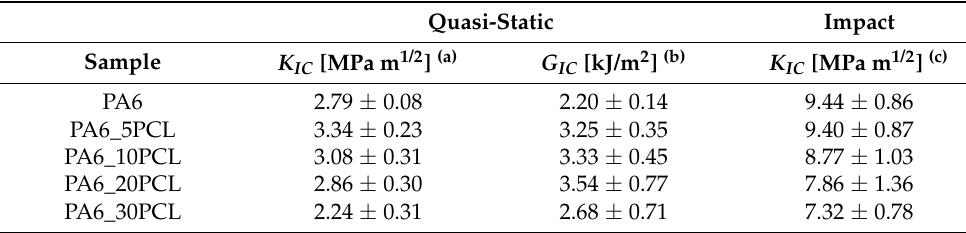
Table 3. Results describing the fracture behavior of the prepared PA6/PCL blends in quasi-static and impact mode.